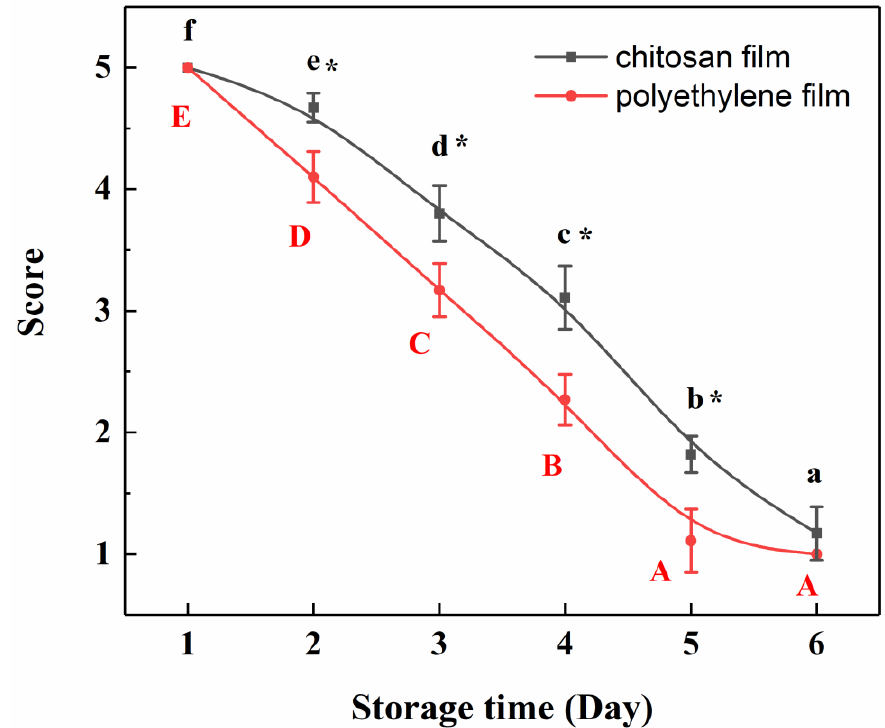
Figure 7. Sensory evaluation results of ground beef sealed with chitosan film and polyethylene film. Small letters in the chitosan film group, p < 0.05; capital letters in the polyethylene film group, p < 0.05; *, p < 0.05, compared with sensory scores of beef samples sealed with polyethylene film.